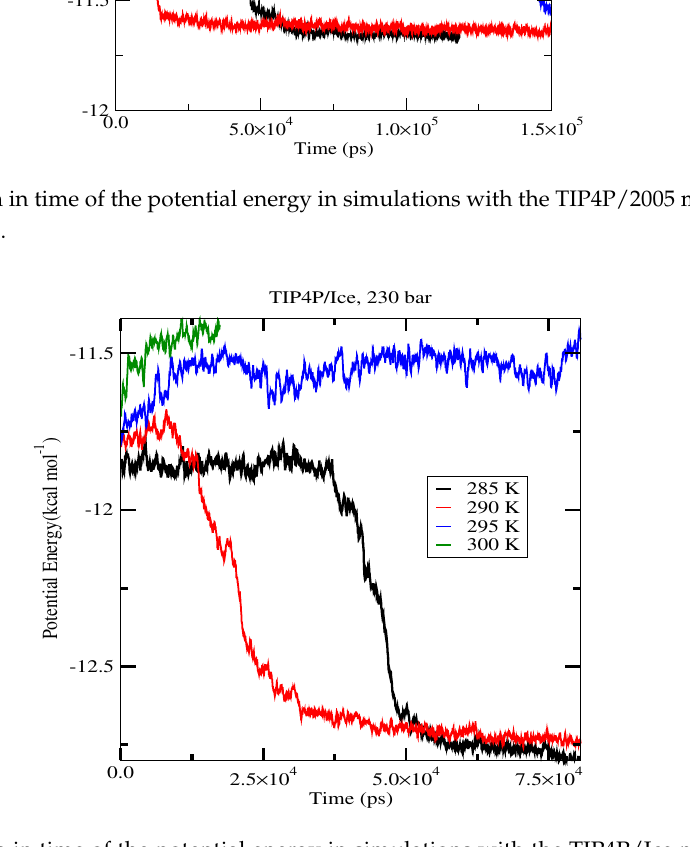
Figure 7. Evolution in time of the potential energy in simulations with the TIP4P/Ice model of the system in Figure